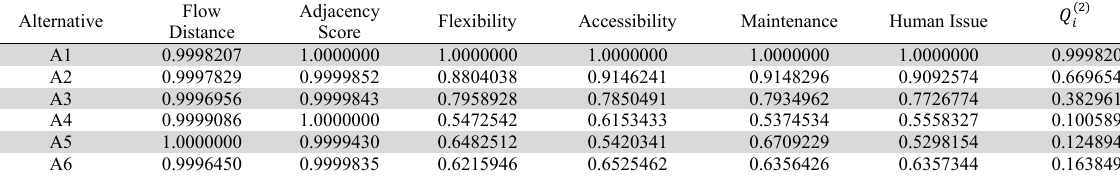
Weighted normalized decision matrix and Performance score of